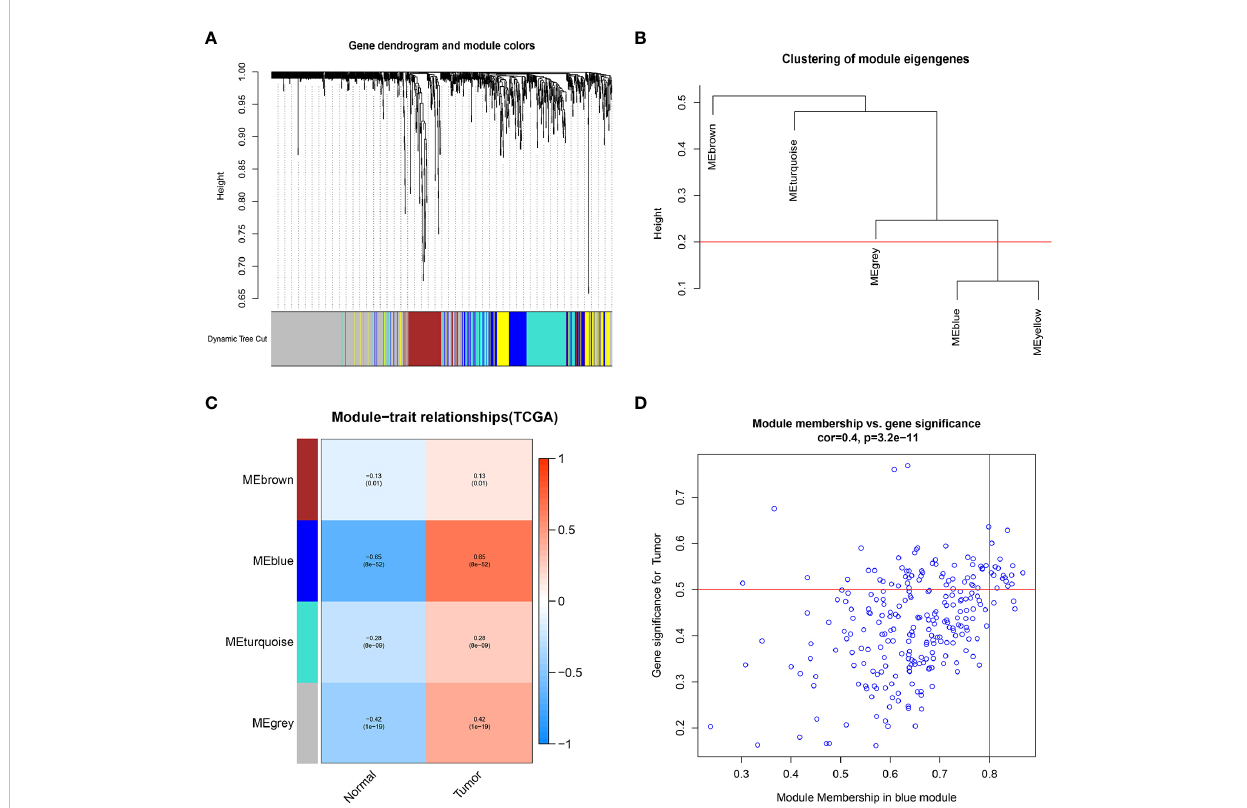
FIGURE 1 Weighted gene co-expression network analysis. (A) Clustering dendrogram of genes, with dissimilarity based on topological overlap, together with assigned module colors. (B) Visual representation of the weight relationship of modular genes in an eigengene network. (C) Module-trait associations: Each row corresponds to a module eigengene and the column to the tumor and normal. Each cell contains the corresponding correlation and p-value. (D) Correlation graph of genes and tumors in the blue